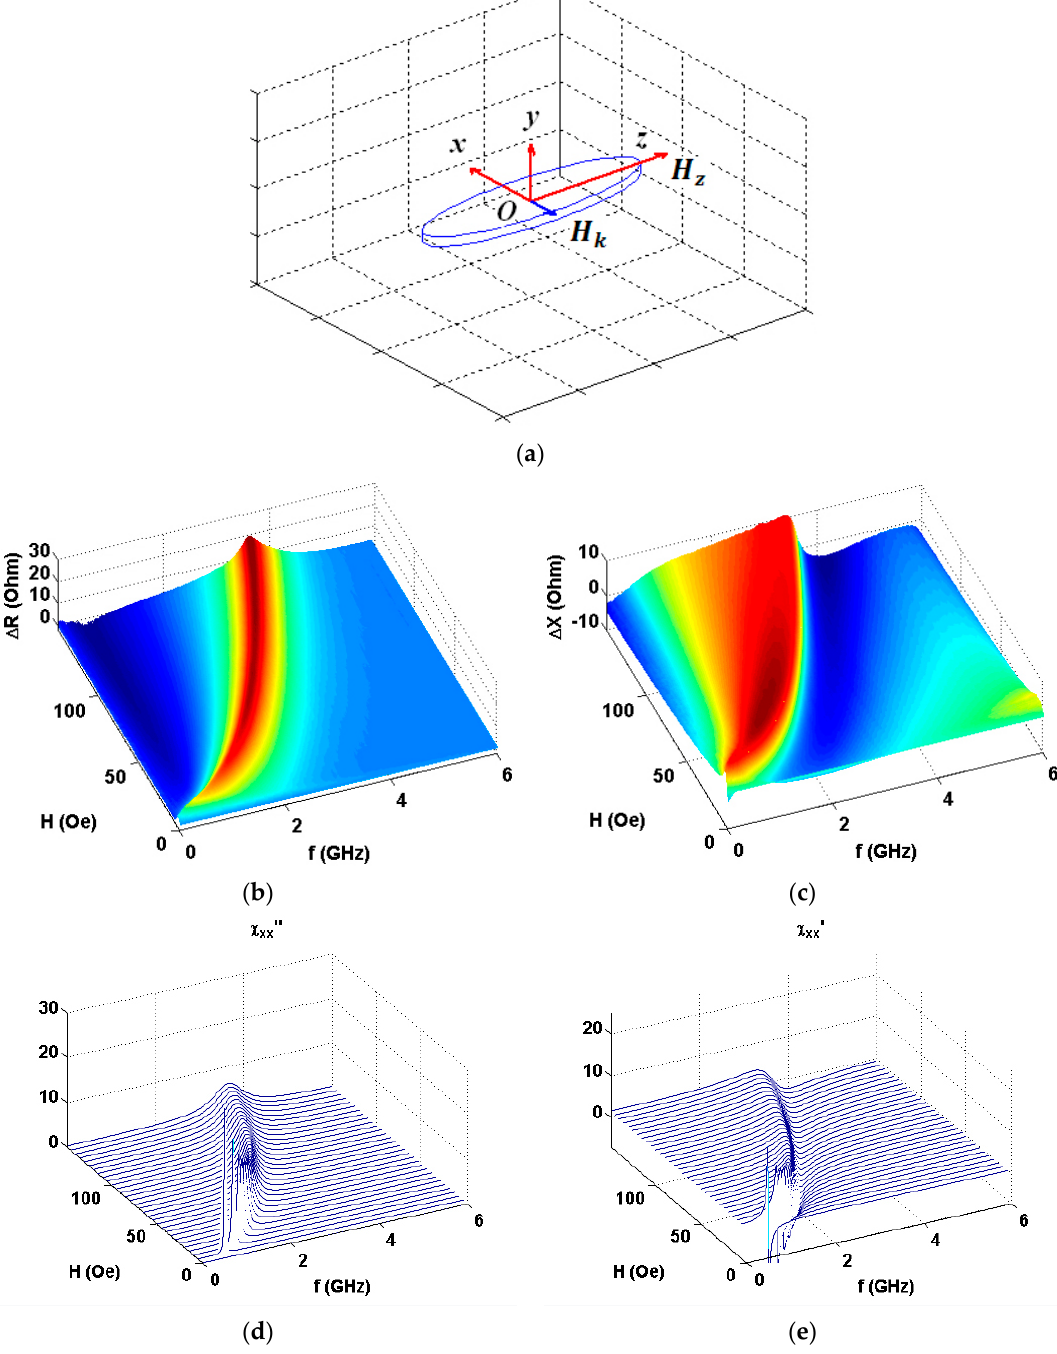
Figure 4. Coordinate system for vector H directed along the long axis of the rectangular [Ti(6)/FeNi(50)] 6 /Ti(6)/Cu(500)/Ti(6)/[FeNi(50)Ti(6)] 6 multilayered GMI element ( a ). Experimental data for the applied field and frequency dependences of the increments of the real ( b ) and imaginary ( c ) parts of the total impedance of GMI element. Model calculations for imaginary ( d ) and real ( e ) parts of the susceptibility tensor corresponding to the real and imaginary parts of the impedance variations accordingly.